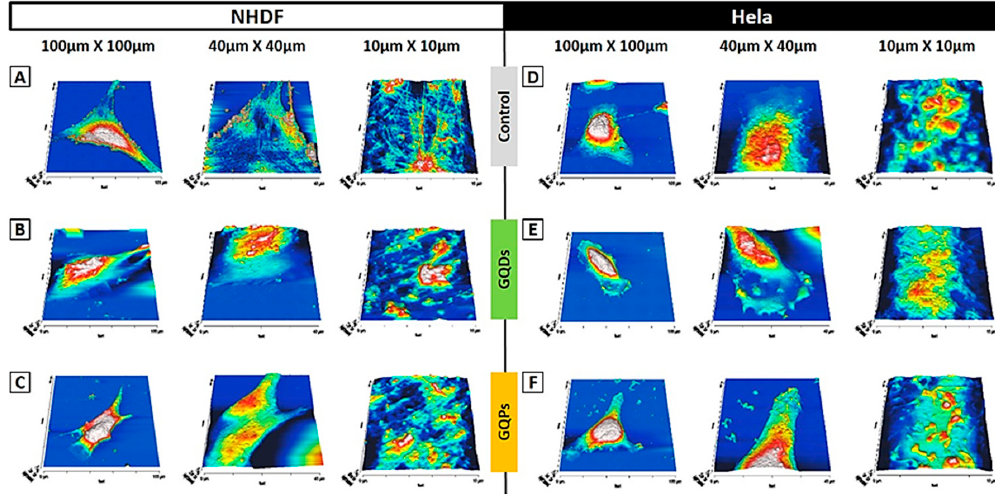
Figure 7. AFM image of cells after treatment of GQDs and GQPs. AFM 3D images of control cells; ( A ) NHDF, ( D ) HeLa. In the case of NHDF, compared to the control, the cell surface became much rougher when the cells were treated with ( B ) GQDs and broader when the cells were treated with ( C )